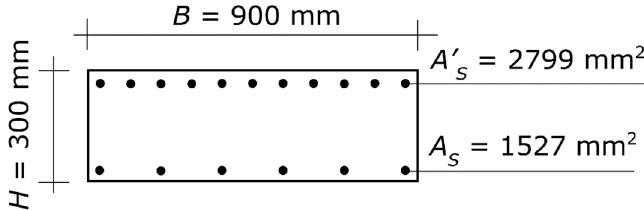
Figure 6. Second application example. Cross-section of the two beams at the beam–column joint. The diagram shows the concrete section and the longitudinal steel reinforcement, while it does not show the stirrups (which play no direct role in column proportioning). The symbols are those defined in Section SubSection 2.1.